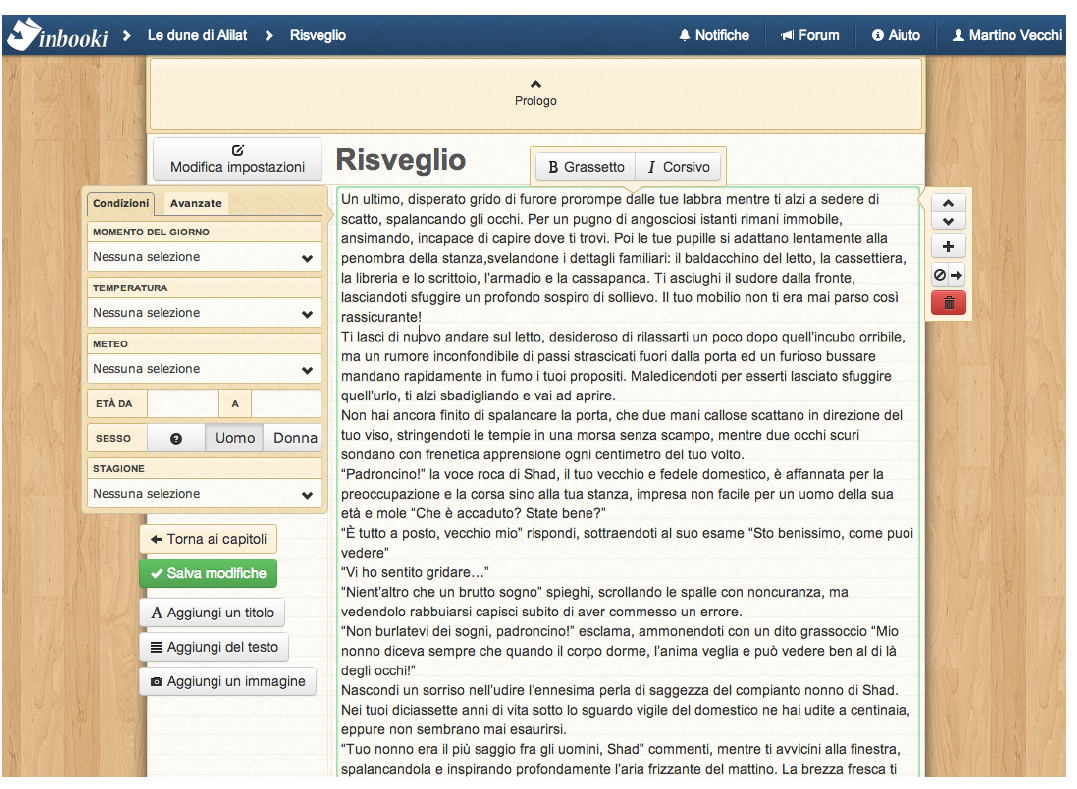
Figure 3. Inbooki chapter text